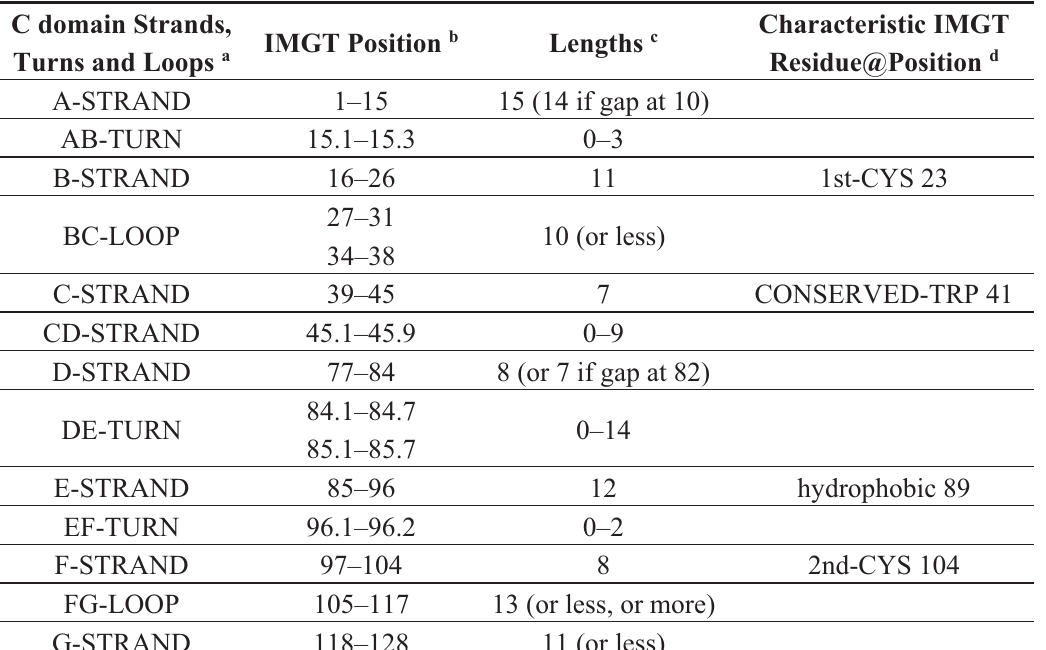
Table 4. IG C-DOMAIN strands, turns and loops, IMGT positions and lengths, based on the IMGT unique numbering for C